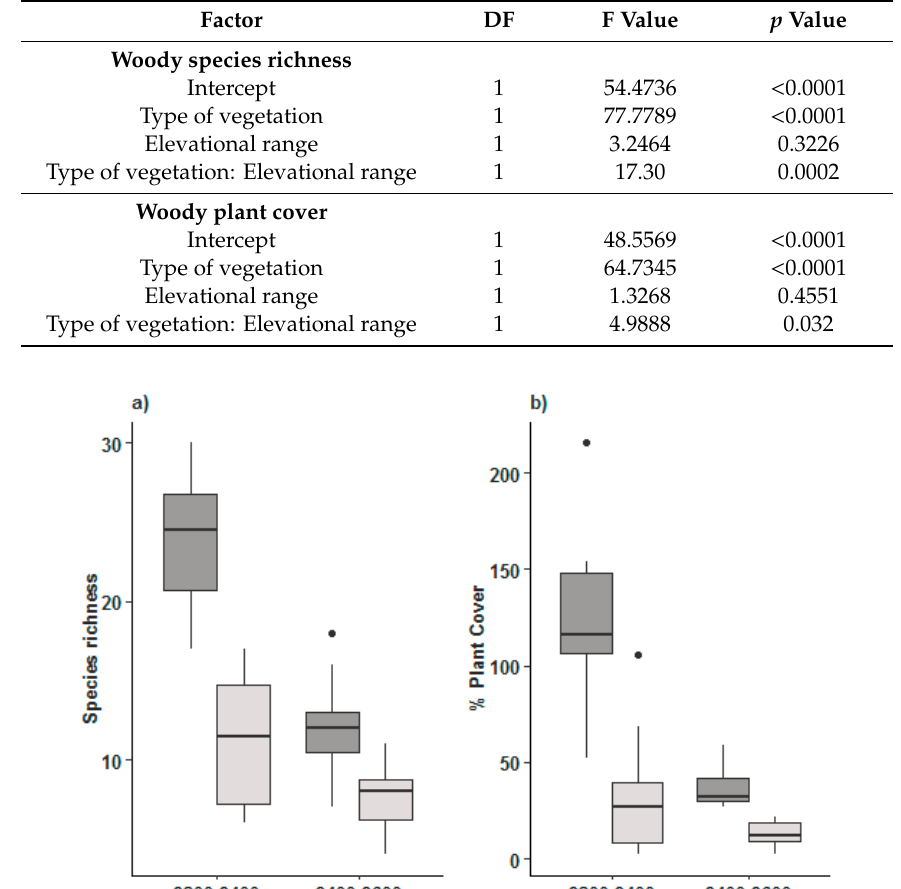
Table 3. Influence of elevational range and type of vegetation on species richness and plant cover of woody vegetation according to an ANOVA analysis obtained from the linear mixed model (LMM).